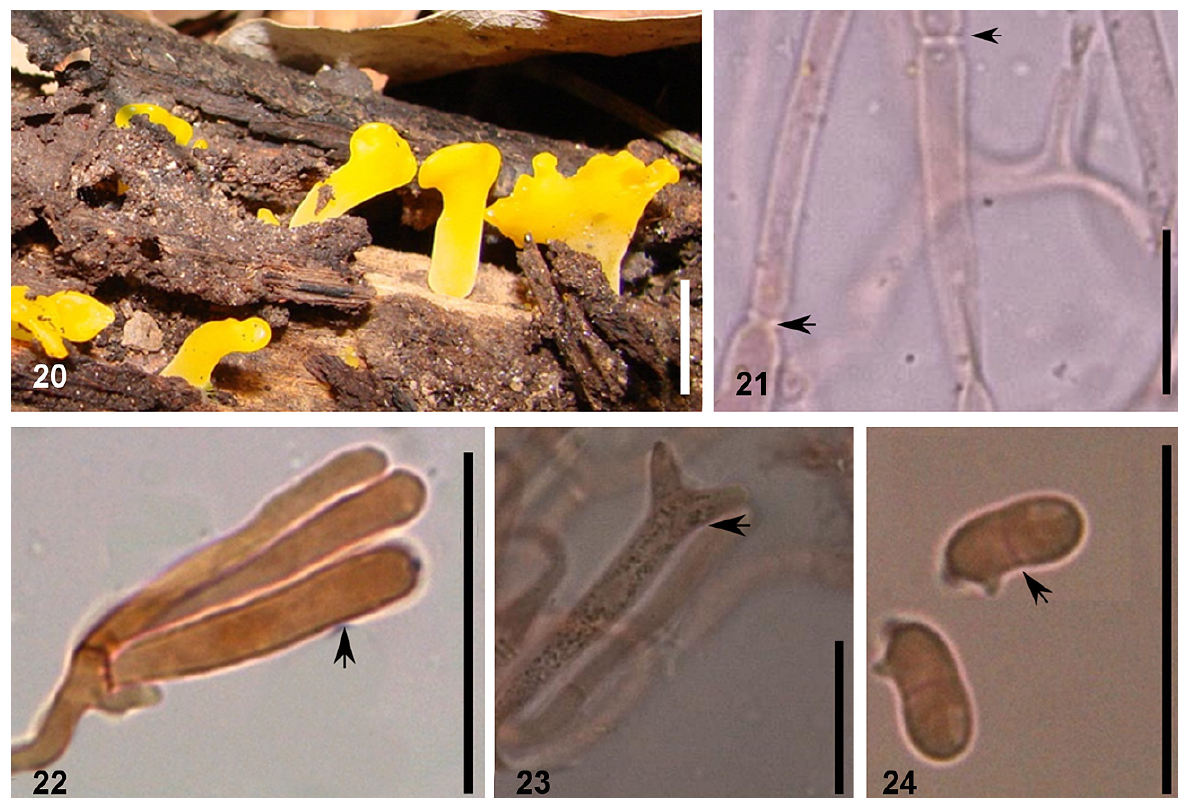
Figures 20–24. Dacryopinax spathularia . 20. Basidiomata (HUEG 8403), scale bar = 1 cm. 21. Hyphae without clamp connection (black arrow), scale bar = 10 µm. 22. Probasidia (black arrow), scale bar = 20 µm. 23. Immature metabasidia (black arrow), scale bar = 10 µm. 24. Basidiospore with septation (black arrow) scale bar = 20